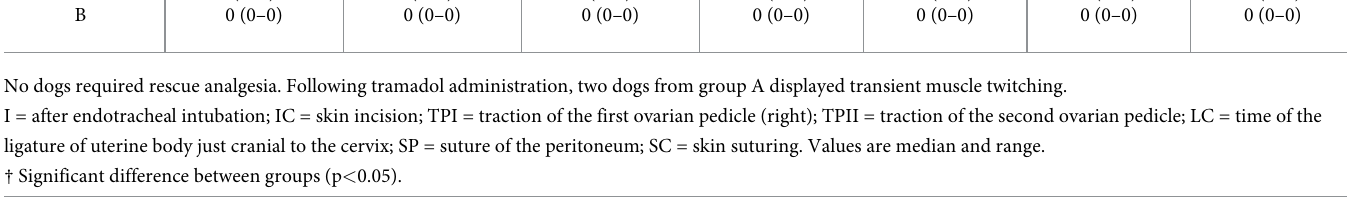
Table 3. Cumulative pain score (CPS).